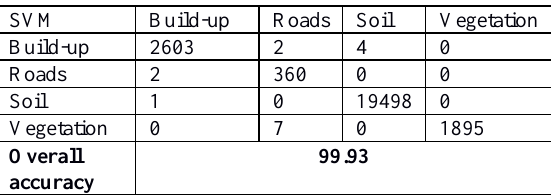
Table 2. Accuracy of predicted materials by SVM classification technique.